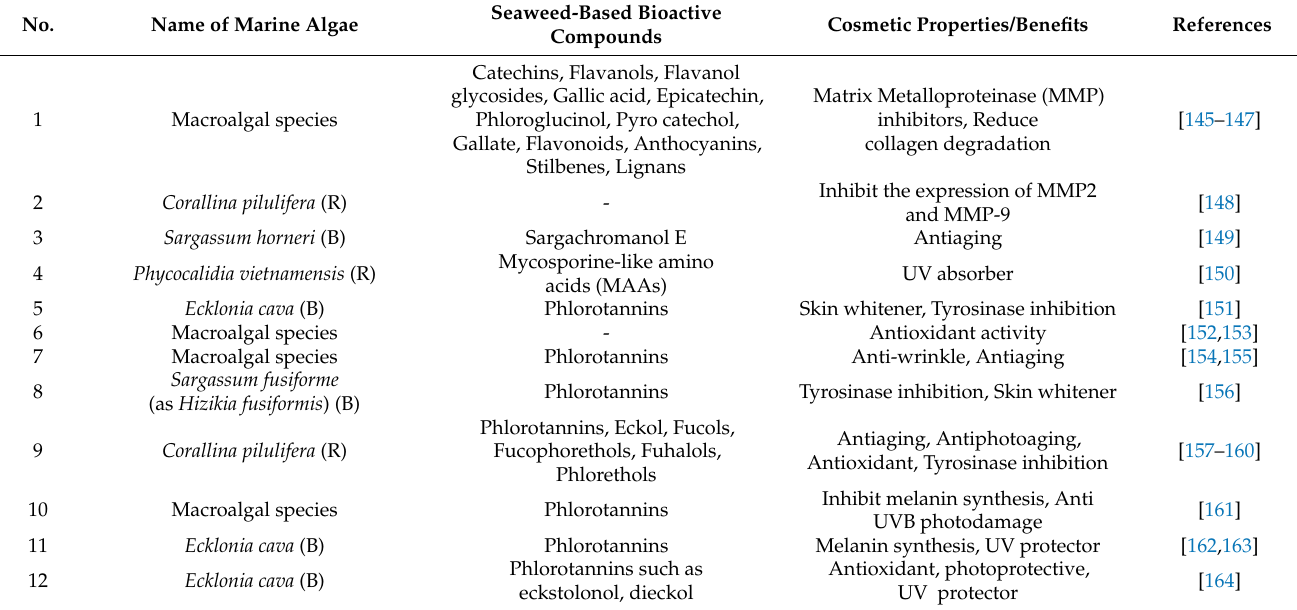
Table 1. Applications of marine macroalgae-derived phenolic compounds in skin